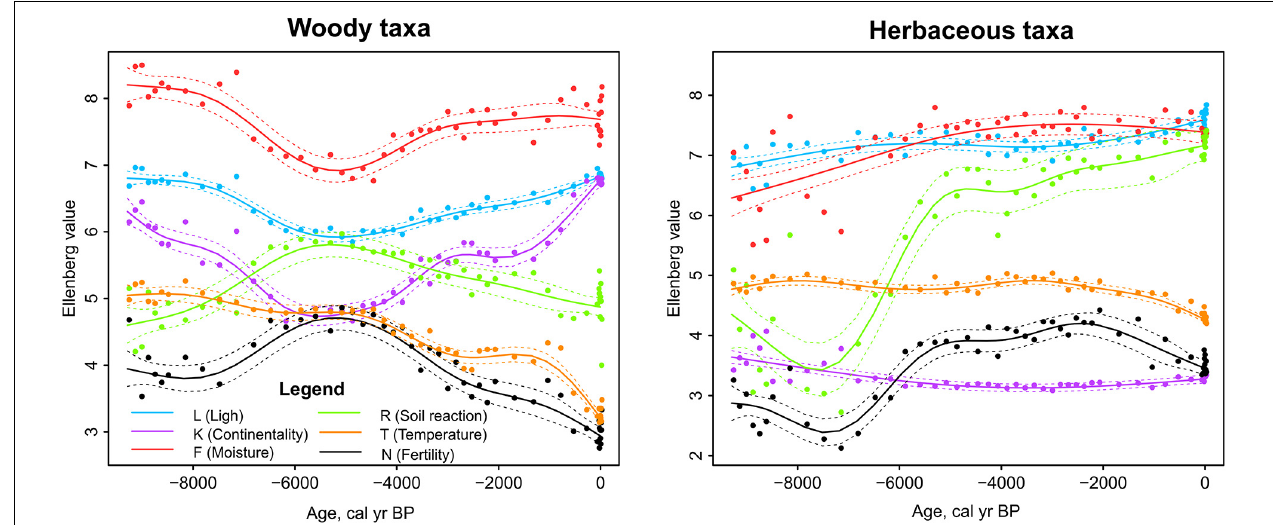
FIGURE 8 | Sedimentary pollen based reconstructions of Ellenberg indicator values (EIVs) in Kanna spring fen. Generalized additive models in relation to time. Dashed lines enclose the 95% confidence intervals of trend lines.